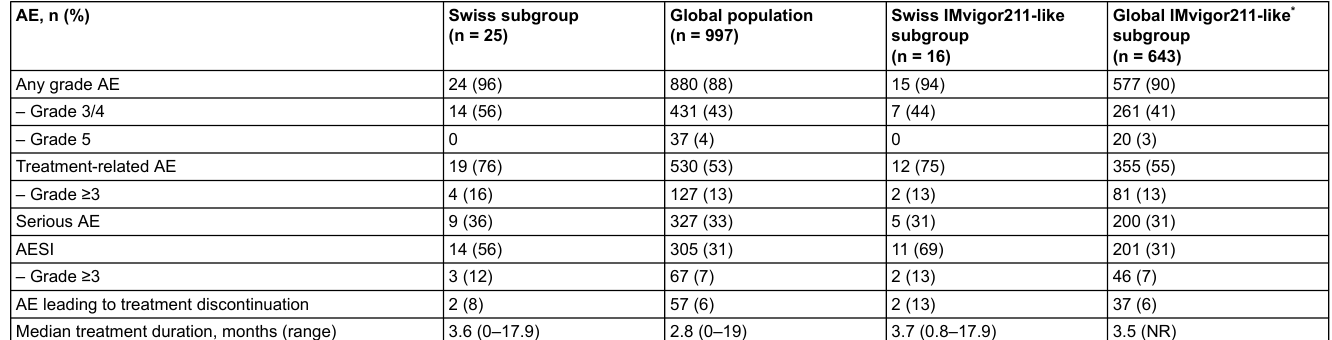
Table 2: Overview of safety by